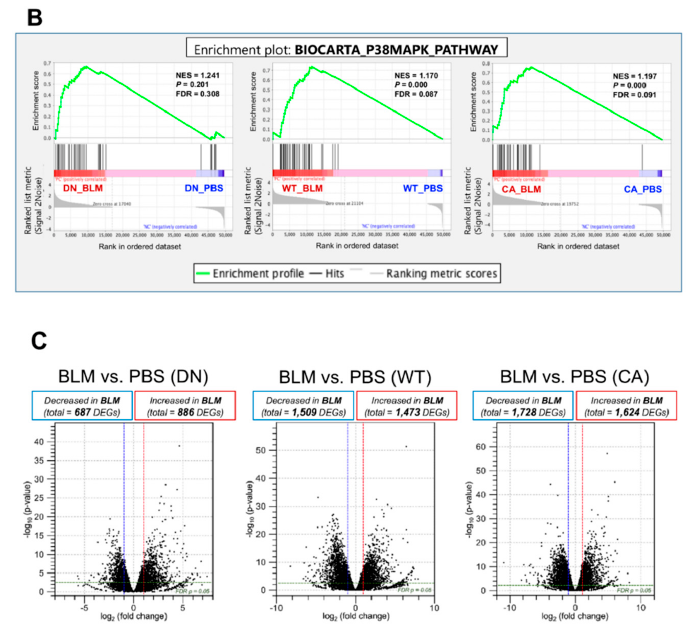
Figure 2. Expression profiling of BLM- and PBS-treated lungs in three di ff erent mouse genotypes. Three samples from each group were sequenced. ( A ) Principal component analysis of RNA sequencing datasets among the BLM- and PBS-treated three mouse groups (left). Hierarchical clustering shown in a heatmap of gene expression profiles between the BLM- and PBS-treated groups (right). The red and blue strips represent upregulated and downregulated genes in each group, respectively. ( B ) Gene set enrichment analysis of di ff erential expression in the p38 MAPK pathway between the BLM- and PBS-treated groups of three mouse genotypes. The normalized enrichment scores (NES), normal p -values, and false discovery rate (FDR) q values are indicated. ( C ) Volcano plot of di ff erentially expressed genes altered by BLM treatment among three mouse groups. Upregulated and downregulated genes are discriminated based on log2 fold-change and adjusted FDR p -value ( < 0.05). Int. J. Mol. Sci. 2020 , 21 , x FOR PEER REVIEW